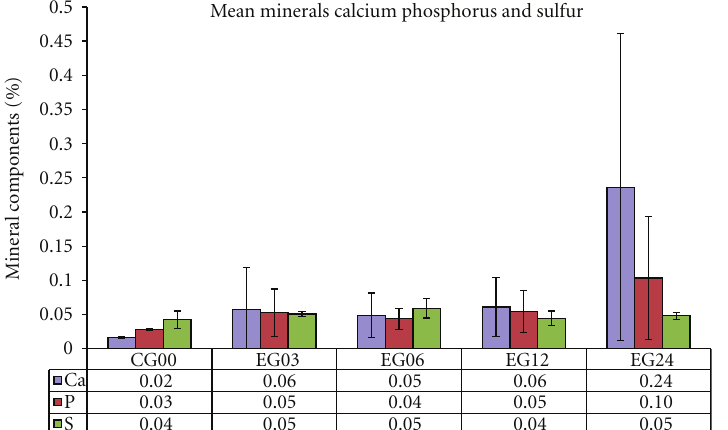
Figure 5: Mean concentrations of calcium, phosphorus, and sulphur found in the implanted plugs according to follow-up time (EGs) and PVA not implanted in vivo (GC00). Confidence level ( P < 0 . 05) was obtained through Anova multiple comparison analysis statistics.